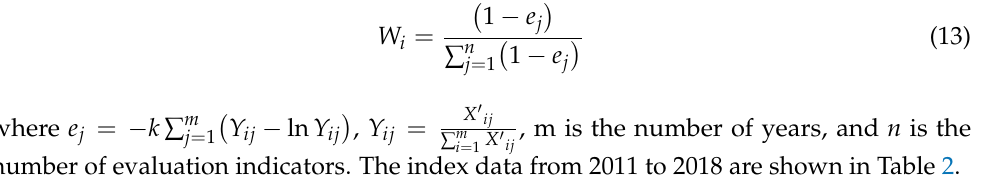
Table 2. The index data of 9